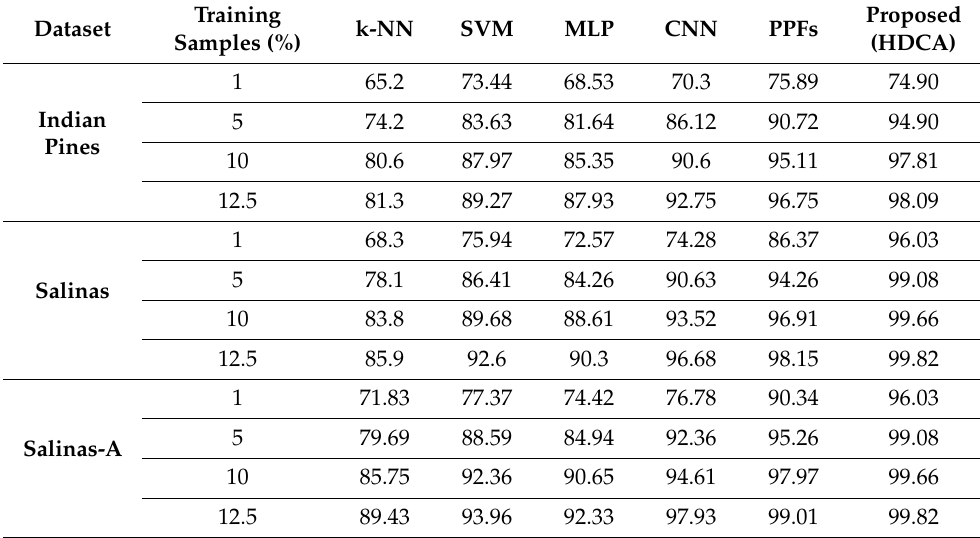
Table 8. Overall accuracies of the proposed method compared to other traditional and deep learning-based